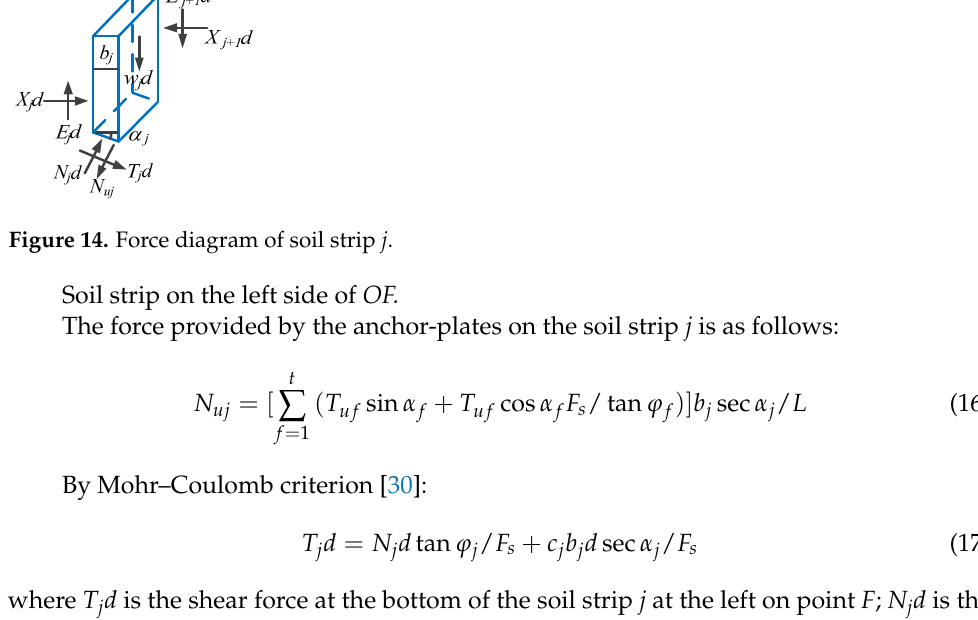
Figure 13. Diagram of stability analysis for the second type of slip surface.